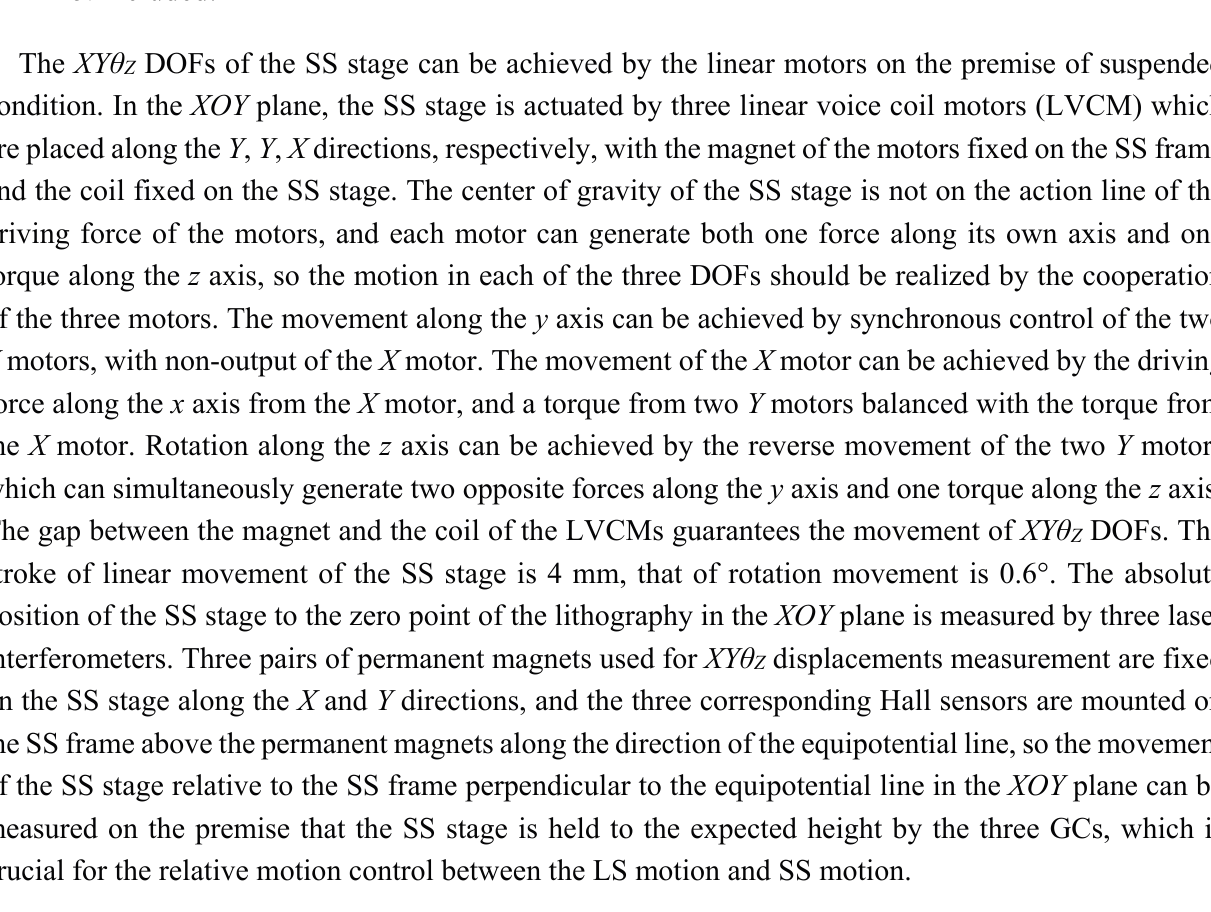
Figure 1. Schematic illustration of the proposed short stroke stage with 3D Hall sensors measurement system, in which the LS (long stroke) motors and the aerostatic guides are not